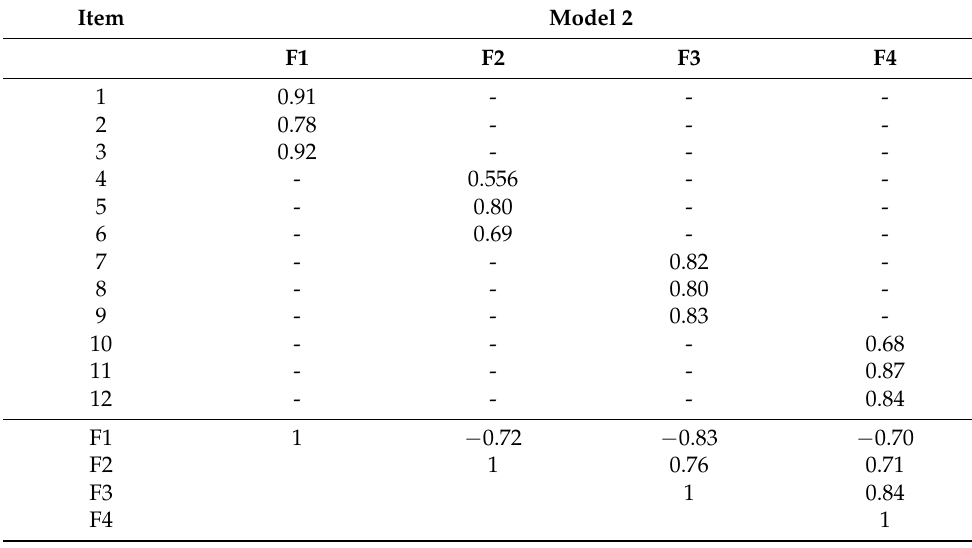
Table 3. Standardized solutions and correlations between factors in Model 2.